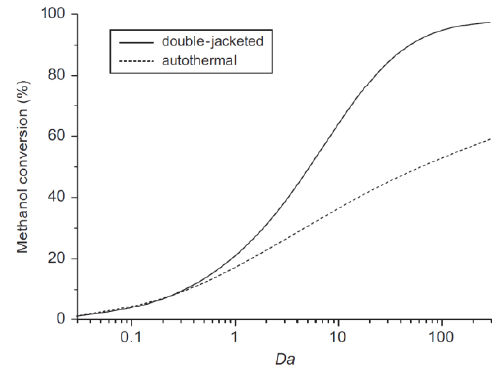
Figure 8. Methanol conversion vs Damköhler number: comparison between the double-jacketed MR and an equivalent autothermal conventional reactor. With permission of reprint of Elsevier from Wu and Fu [54].